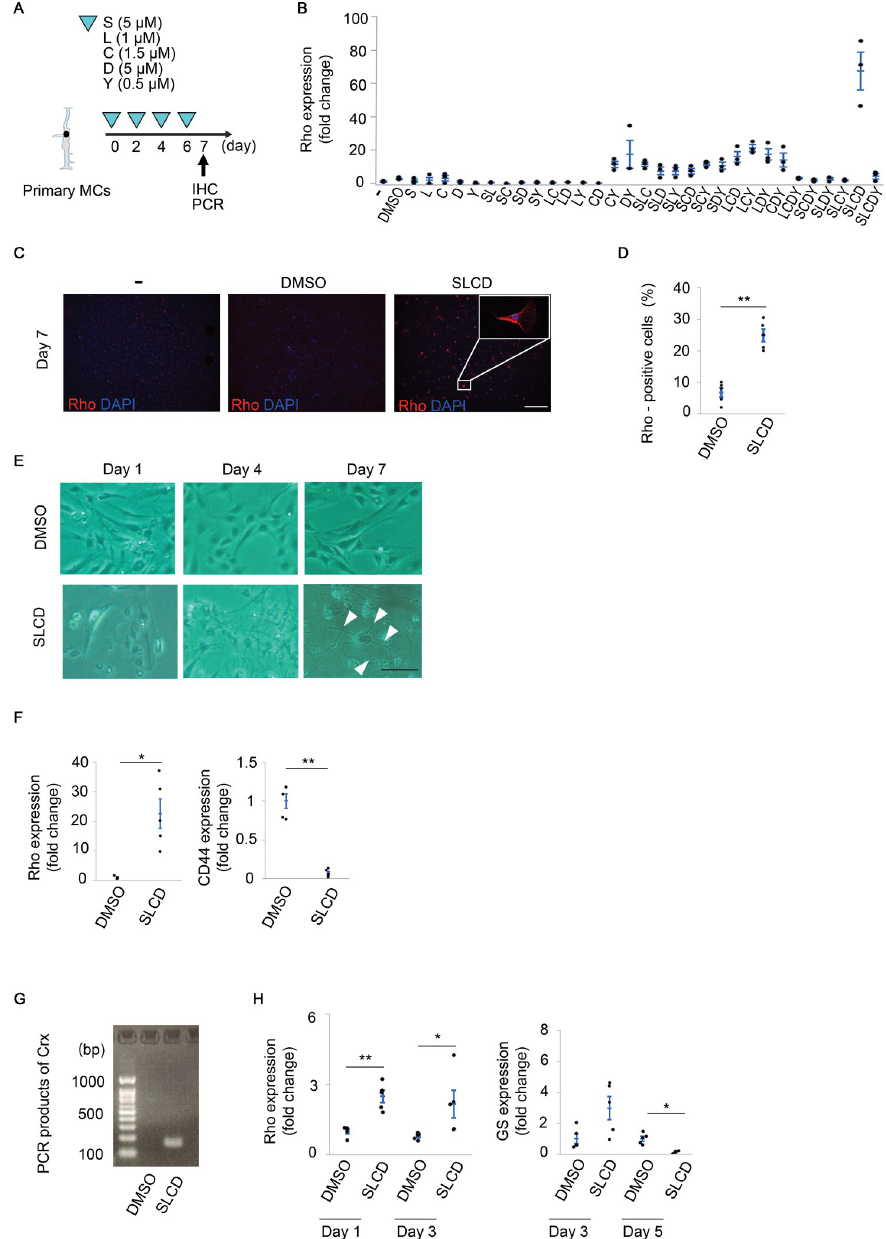
Fig 1. Screening of small molecule compounds for converting primary MCs into photoreceptor-like cells. A) Time course of the in vitro experiments. MCs were stimulated with five compounds every 2 days. S, SB431542 (5 μ M); L, LDN193189 (1 μ M); C, CHIR99021 (1.5 μ M); D, DAPT (5 μ M); Y, Y-27632 (0.5 μ M). B) Comparison of the Rho mRNA expression levels for all 31 combinations using real-time qPCR (n = 3). C) and D) Immunofluorescence of Rho (C) and the corresponding quantitative results (D) on day 7 after the stimulation with SLCD. Scale bar = 100 μ m (n = 5). E) Microscopic images of the cultured cells. A neurite-like structure (arrowheads) could be observed on day 7 after the stimulation with SLCD (n = 5). Scale bar = 100 μ m. F) Real-time qPCR results of Rho and CD44 on day 7 after the stimulation with SLCD (n = 5). G) PCR products of Crx on day 7 after SLCD stimulation. The Crx expression level was below the detection sensitivity in the control group (n = 5). H) Real-time qPCR results of the Rho and glutamine synthetase (GS) expression in TR-MUL5 (n = 5). All data are presented as the mean ± SEM. � p < 0.05, �� p < 0.01, as per Wilcoxon rank sum